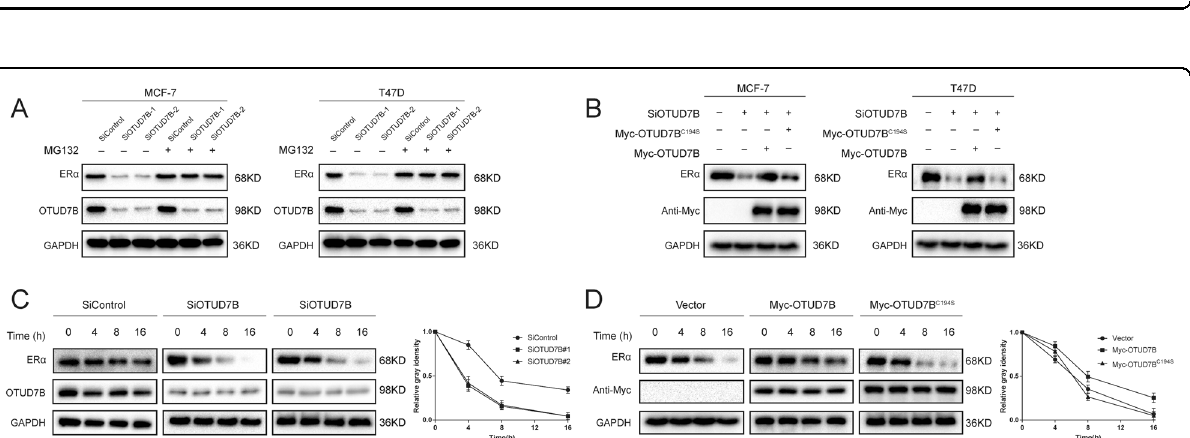
Fig. 4 OTUD7B associates with ER α . A An immuno fl uorescence assay demonstrated that OTUD7B and ER α at least partially colocalized in MCF7 and T47D cells. B Co-IP assay revealed an association between endogenous OTUD7B and ER α in MCF-7 cells. MCF-7 cells were harvested with RIPA lysis buffer. Co-IP was performed using antibody as indicated. C Puri fi ed His-OTUD7B was incubated with GST- ER α or GST protein. The interacted OTUD7B was detected via western blot. D ER alpha domain structure and deletion mutants used in the study. E , F OTUD7B interacted with ER α through its AF1 domain. HEK293 cells were transfected with 2 μ g Myc-OTUD7B together with HA- ER α full length or mutants. After 24 h, cells were harvested with NP-40 lysis buffer. Co-IP was performed using Myc antibody. The possible interacted ER α domains were detected by HA antibody.